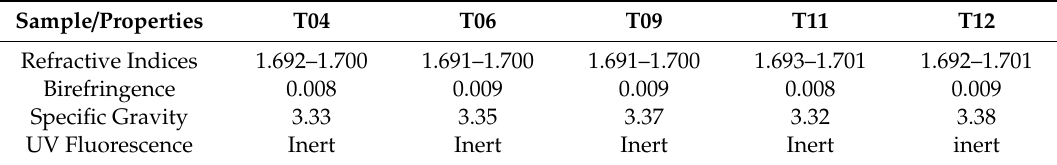
Table 1. General properties of tanzanite samples in this